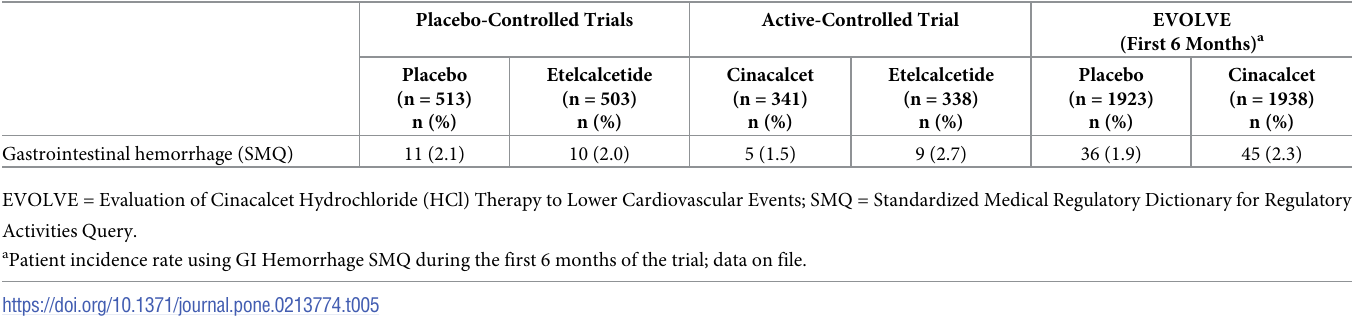
Table 5. Patient incidence of treatment-emergent gastrointestinal bleeding events with historic control